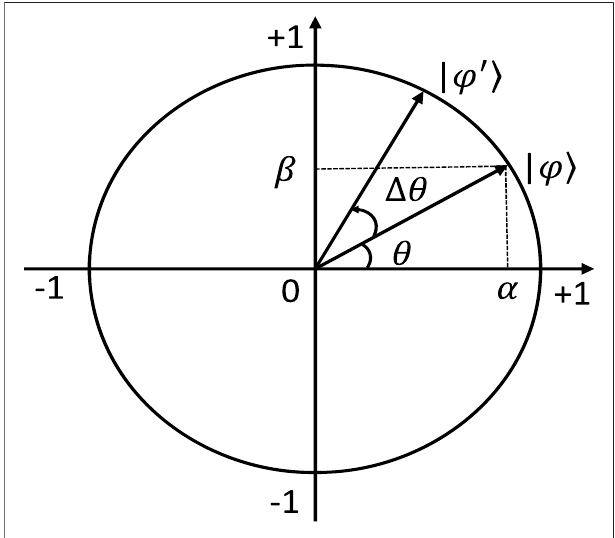
FIGURE 2 | Quantum rotation angle updating.